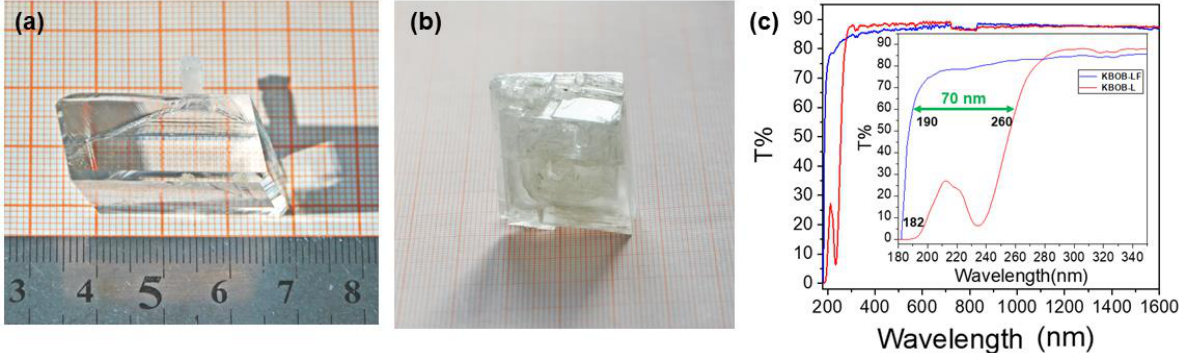
Figure 1. ( a , b )The photographs of KBOB-L and KBOB-LF crystals, respectively. ( c ) The transmittance spectra of KBOB-LF and KBOB-L, respectively.